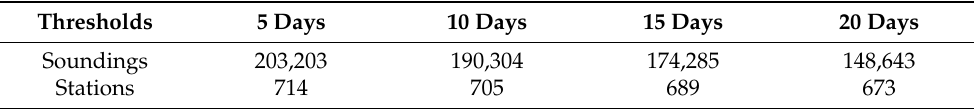
Table A1. The total number of stations and soundings that are used for calculating monthly ra- diosonde P LRT under different thresholds where daily P LRT values are available on at least 5, 10, 15, or 20 days in a